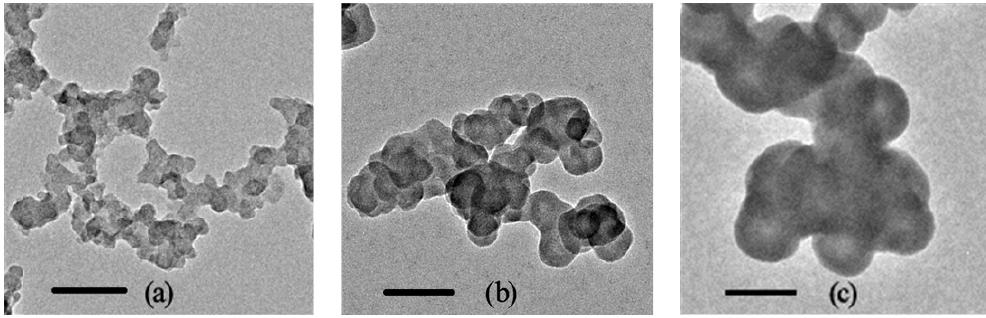
Figure 1. TEM images of NCBs. ( a ) Printex 90; ( b ) Printex G; and ( c ) Flammruss 101. The scale bars correspond to 100